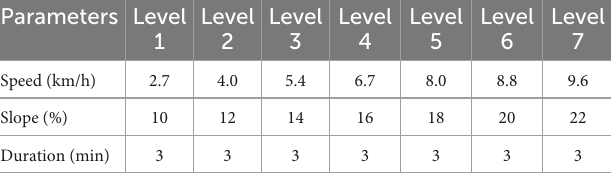
TABLE 2 Bruce program levels of exercise